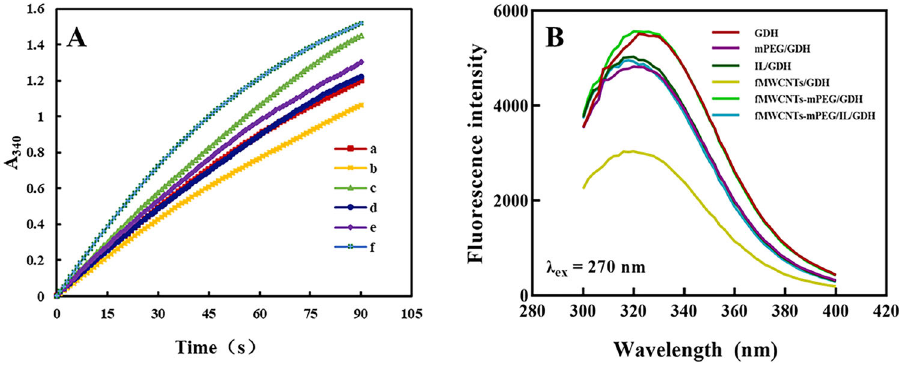
Figure 7. ( A ) Initial reaction rates of (a) GDH, (b) fMWCNTs/GDH, (c) mPEG/GDH, (d) IL/GDH, (e) mPEG/fMWCNTs/GDH, and (f) mPEG/fMWCNTs/IL/GDH. ( B ) Fluorescence spectra of GDH, mPEG/GDH, IL/GDH, fMWCNTs/GDH, fMWCNTs-mPEG/GDH, and IL/fMWCNTs-mPEG/GDH in PBS (50 mM, pH 7.0), at 25 ± 1 °C.